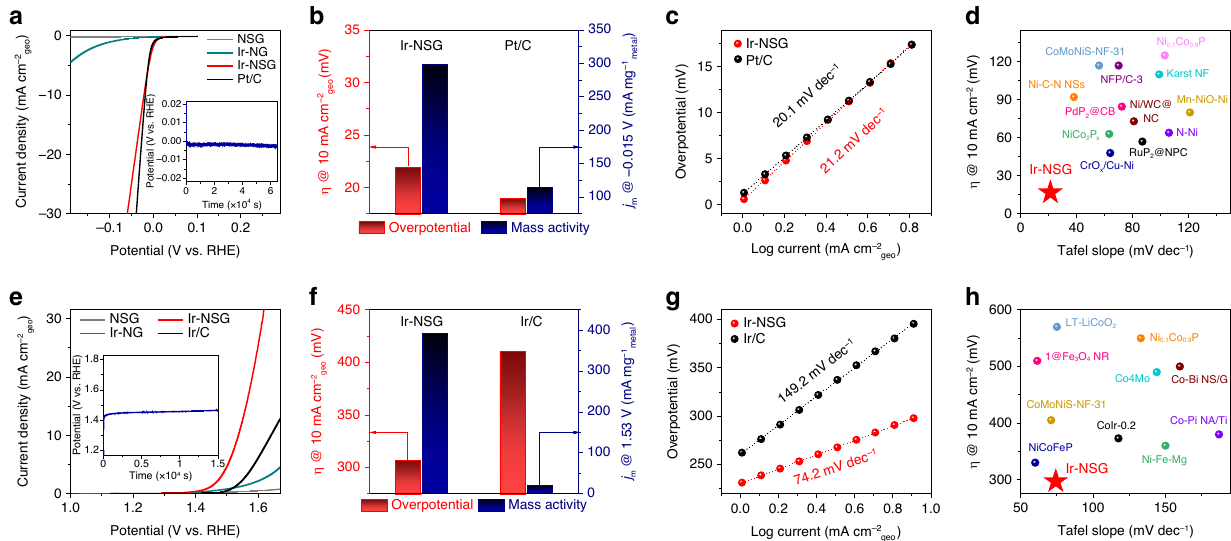
Fig. 2 HER and OER performance of the Ir-NSG catalyst in neutral electrolyte. a HER polarization curves of Ir-NSG and Pt/C acquired at a sweep rate of 1 mV s − 1 in Ar-saturated 1 M PBS. Inset shows the chronopotentiometry of Ir-NSG. b Comparison of overpotential ( η ) to drive a current density of 10 mA cm − 2 and metal-mass speci fi c activity ( j m ) at − 0.015 V (vs. RHE) between Ir-NSG and Pt/C. c The corresponding Tafel plots for Ir-NSG and Pt/C. d Comparison of overpotential (@ 10 mA cm − 2 ) and Tafel slope for various state-of-the-art HER catalysts in neutral medium. e Polarization curves of Ir- NSG and Ir/C acquired at a sweep rate of 1 mV s − 1 in 1 M PBS. Inset shows the chronopotentiometry of Ir-NSG. f Comparison of overpotential to drive a current density of 10 mA cm − 2 and metal-mass speci fi c activity at 1.53 V (vs. RHE) between Ir-NSG and Ir/C. g The corresponding Tafel plots for Ir-NSG and Ir/C. h Comparison of overpotential (@ 10 mA cm − 2 ) and Tafel slope for various state-of-the-art OER catalysts in neutral medium. All measurements were calibrated with iR -compensation. Catalyst loading: 0.3 mg cm − 2 . Rotation speed: 1600 rpm. The overpotential of Ir-NSG was determined from LSV curve obtained at a scan rate of 5 mV s − 1 and other values were plotted from references in Supplementary Table 1 and Supplementary Table 4 for ( d ) and ( h ),